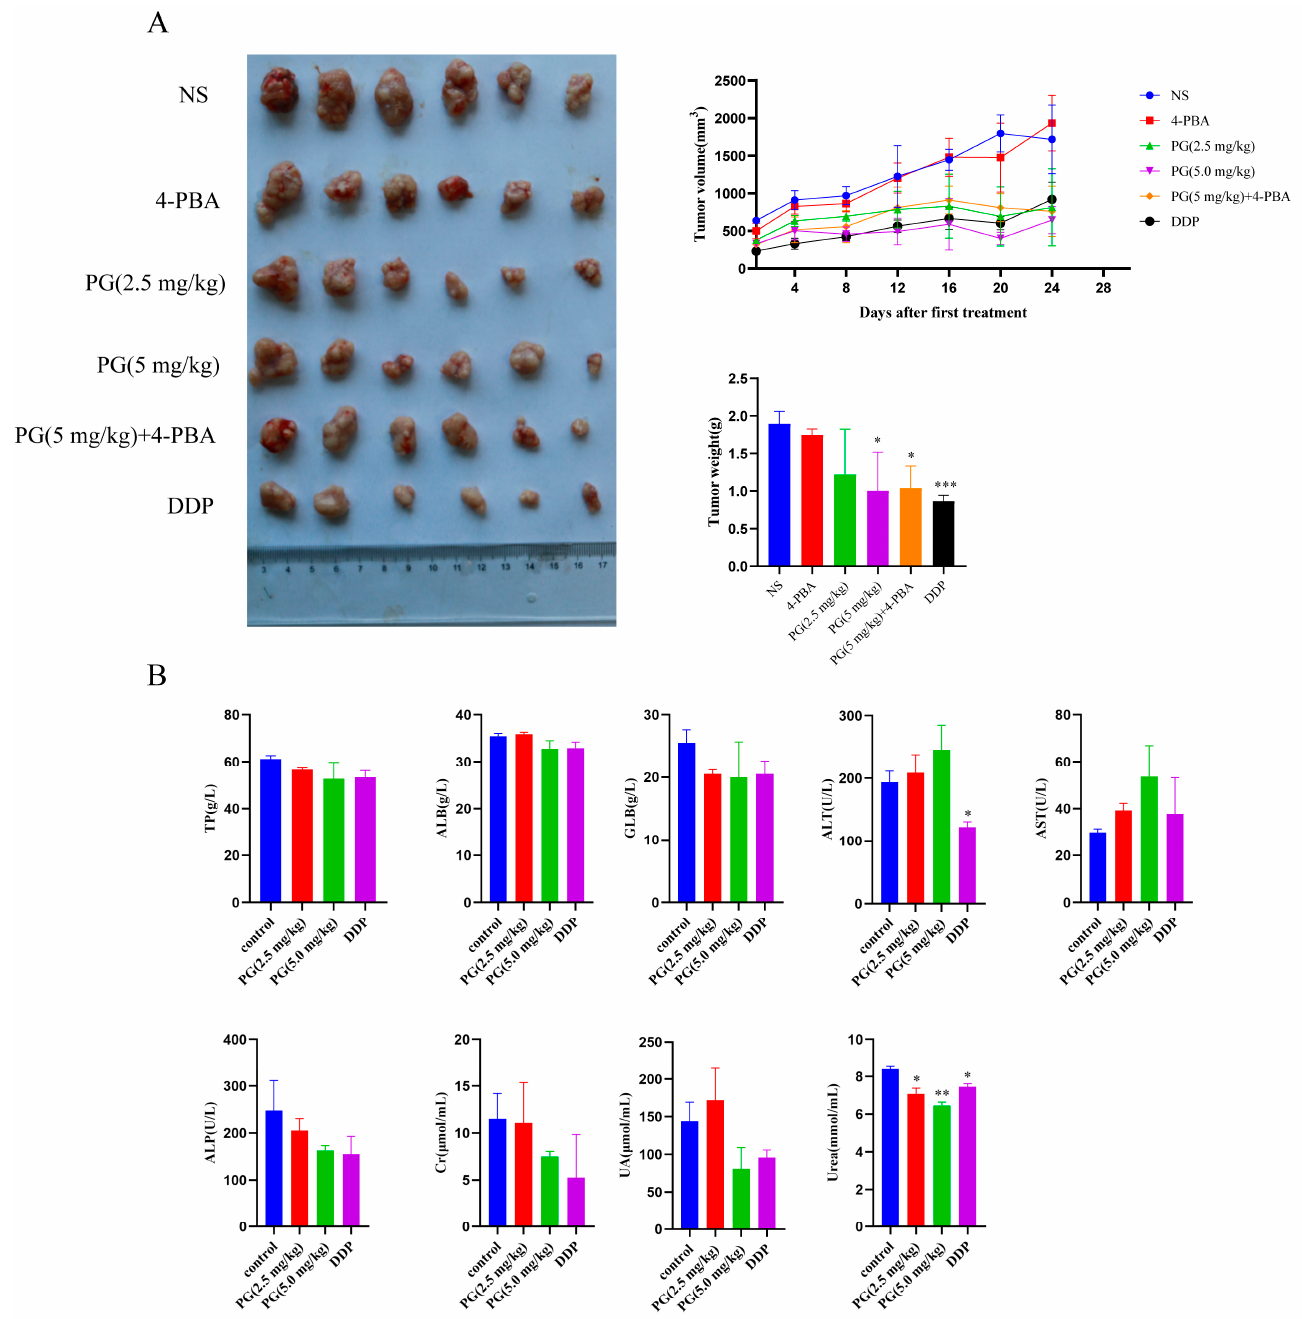
Figure 6. The effect of PG on the proliferation of hepatocellular carcinoma in vivo. ( A ). Effects of PG on the volume and weight of subcutaneously transplanted tumors; ( B ). The effect of PG on the liver and kidney function of nude mice with HepG2. The levels of total aspartate aminotransferase (AST), alanine aminotransferase (ALT), alkaline phosphatase (ALP), albumin (ALB), total protein (TP), creatinine (CR), uric acid (UA) and urea in the blood represent the liver and kidney function of nude mice. PG (2.5 mg/kg), PG (5 mg/kg), PG (5 mg/kg) +4‑PBA, DDP vs. NS, * p < 0.05, ** p < 0.01, *** p < 0.001, n = 6.